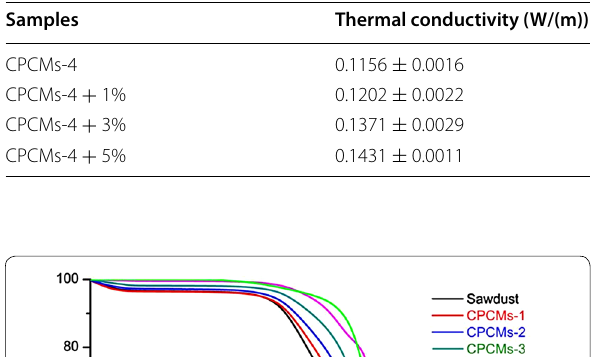
Table 5 Thermal conductivity of CPCMs-4, CPCMs-4 with 1% EG, CPCMs-4 with 3% EG, and CPCMs-4 with 5%